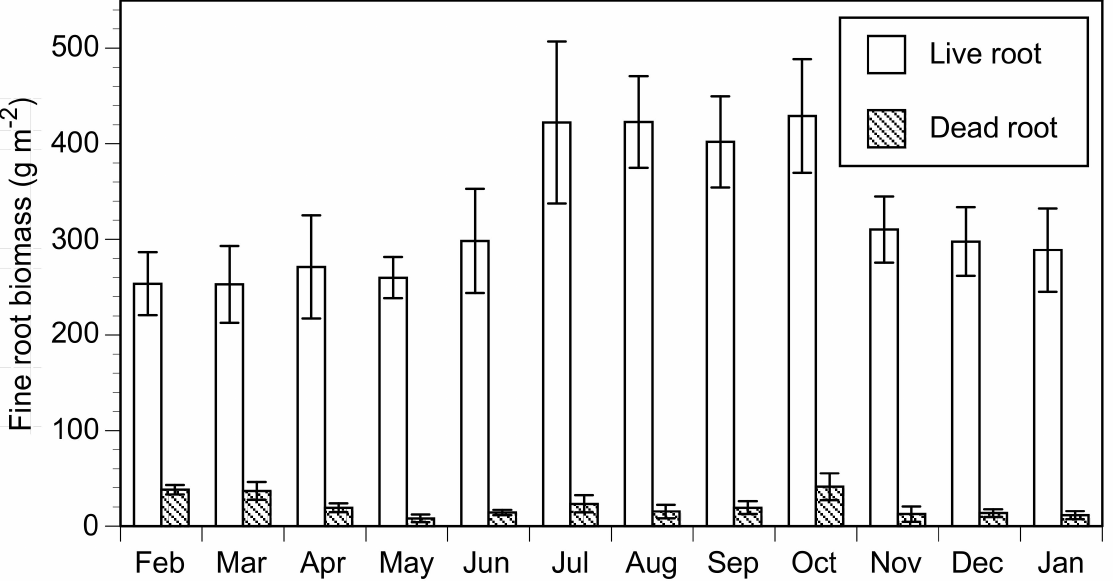
Figure 2. Monthly changes in fine root biomass (g m − 2 ) in a lucidophyllous forest dominated